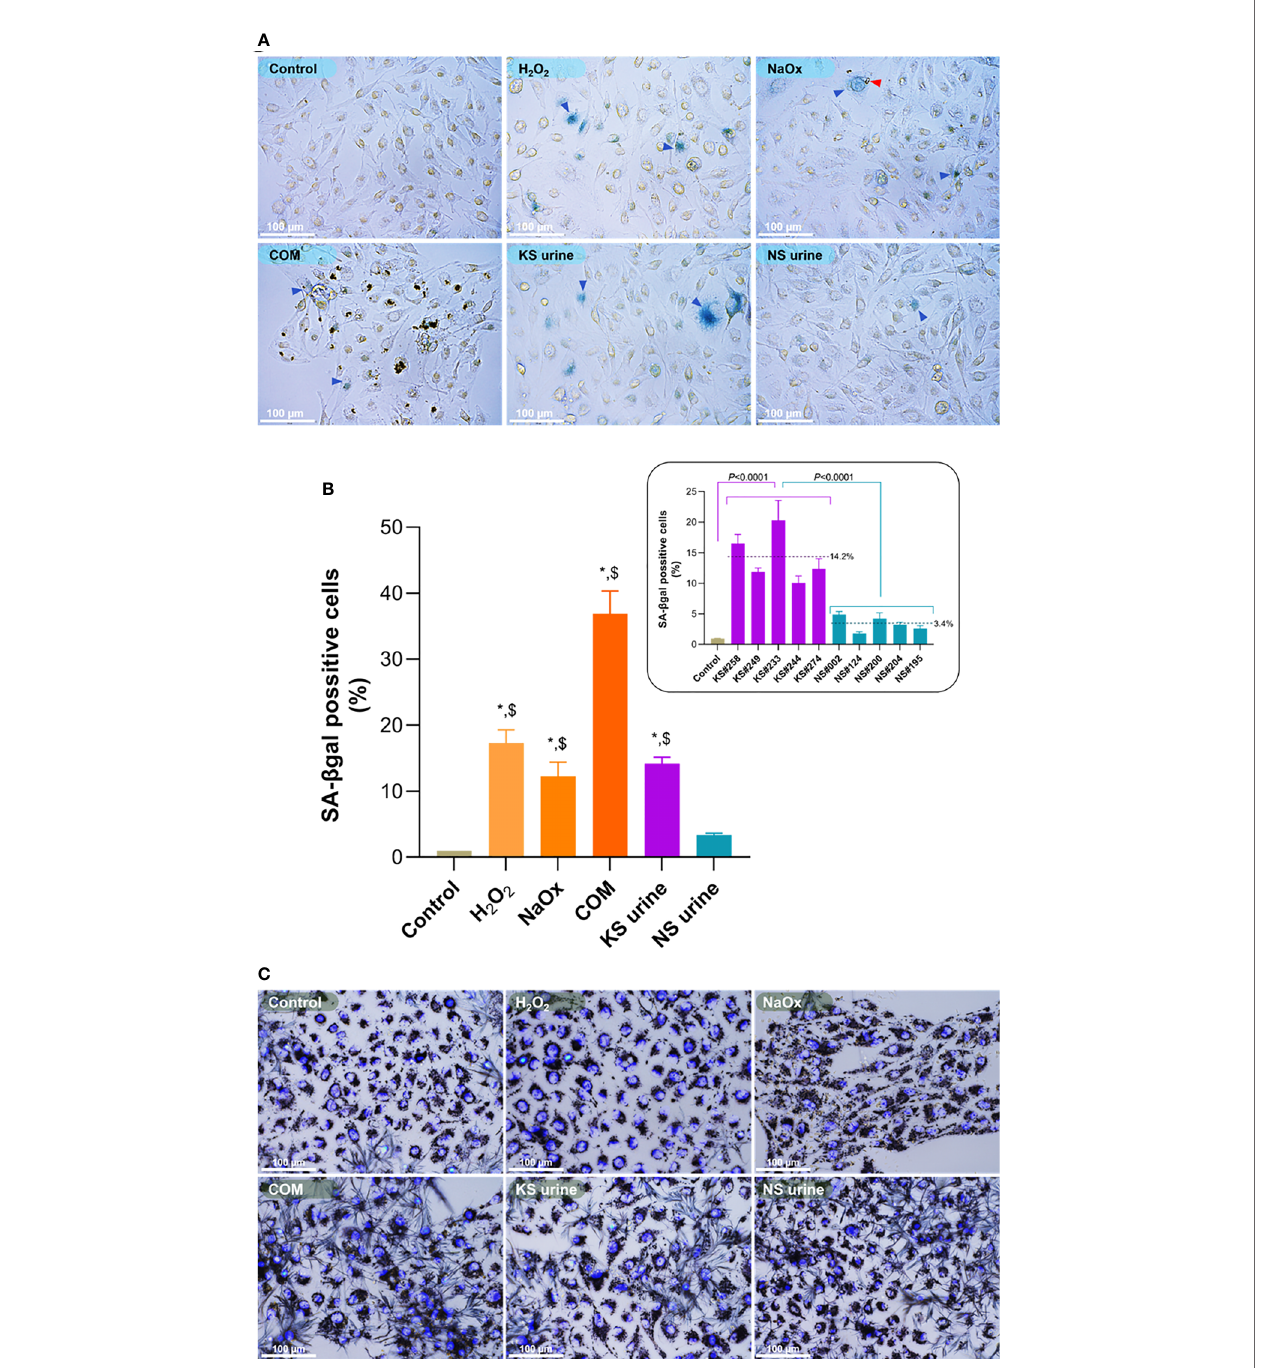
FIGURE 1 | Induction of premature senescence by H 2 O 2 , sodium oxalate (NaOx), calcium oxalate monohydrate (COM), or urine from patients with kidney stones (KS). (A) SA- b gal staining in HK-2 cells treated for 72 hwithH 2 O 2 (25 µM), NaOx (900 µM), COM (25 µg/cm 2 ), urine from patients withKS (10%, v/v) andthose without KS(NS urine) (10%,v/v). More senescent cells (blue arrowheads) were observed incultures of HK-2 cells treated with H 2 O 2 , NaOx, COM, and urine frompatients with KS(KS urine) than in cultures treated with urine fromthose without KSor inuntreated control cultures. The red arrowhead indicates CaOx formedafter addition of NaOx. (B) The proportion of SA- b gal positive cellsincultures treated with H 2 O 2 , NaOx, COM, or urine from patients with KSwere signi fi cantly higher than inuntreated cultures or thosetreatedwith urine from donorswithout KS. Inset: proportion (%) of SA- b gal positive cells after treatment with individualsamples ofurine from patients with KS(KS samples) compared with treatment with individual samples from donors without KS(NS samples). Dashed line and number indicatemean.Error barsindicateSEM of at least triplicate treatments. (C) Cellviability assay showingtreatment with H 2 O 2 , NaOx, COM, andurine at the concentrationsused did not notably change the cellsurvival. Nuclei are stained by 4 ′ ,6- diamidino-2-phenylindole(DAPI).* P < 0.05 vs. Control, $ P < 0.05 vs. NS urine. Magni fi cation